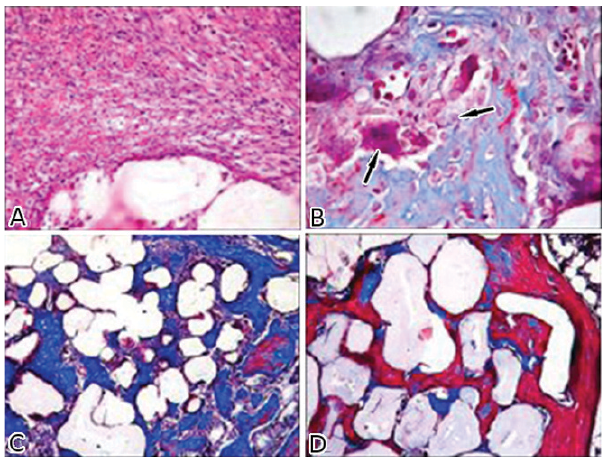
Figure 2 - Histology of tibias implanted with PLLA/PEO that were A) vancomycin-loaded or B) vancomycin-unloaded on the 4 th day, showing evident granulation tissue around the microspheres (arrow) with the initial replacement by bone formation (arrow). This figure also shows the histology of the tibias of animals implanted after 12 days with PLLA/PEO that were C) vancomycin- loaded or D) vancomycin-unloaded, showing trabecular bone encasing the microspheres (Original H&E 10 6 ).